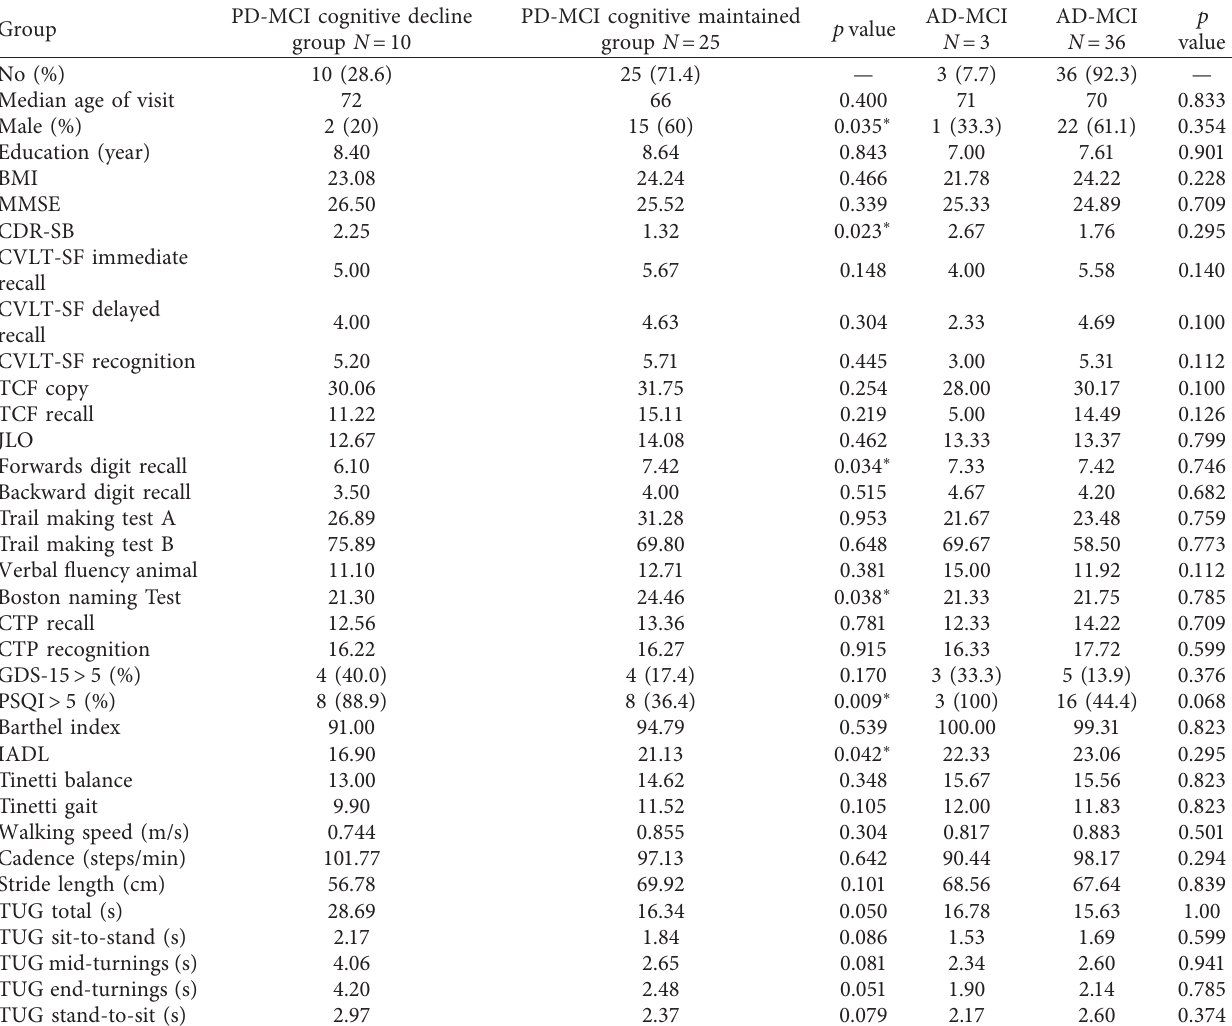
Table 2: Comparison of demographic and clinical characteristics between cognitive decline and cognitive maintained groups.